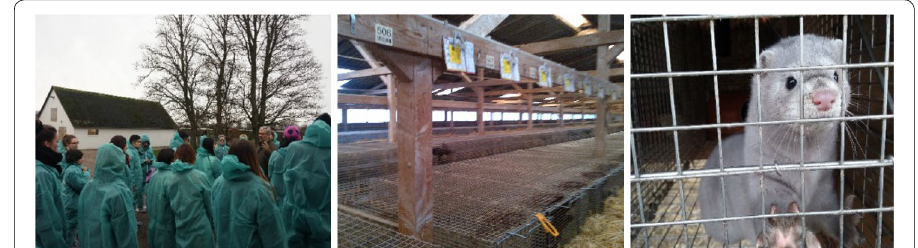
Fig. 8 KF mink farm visit, photographed by the author